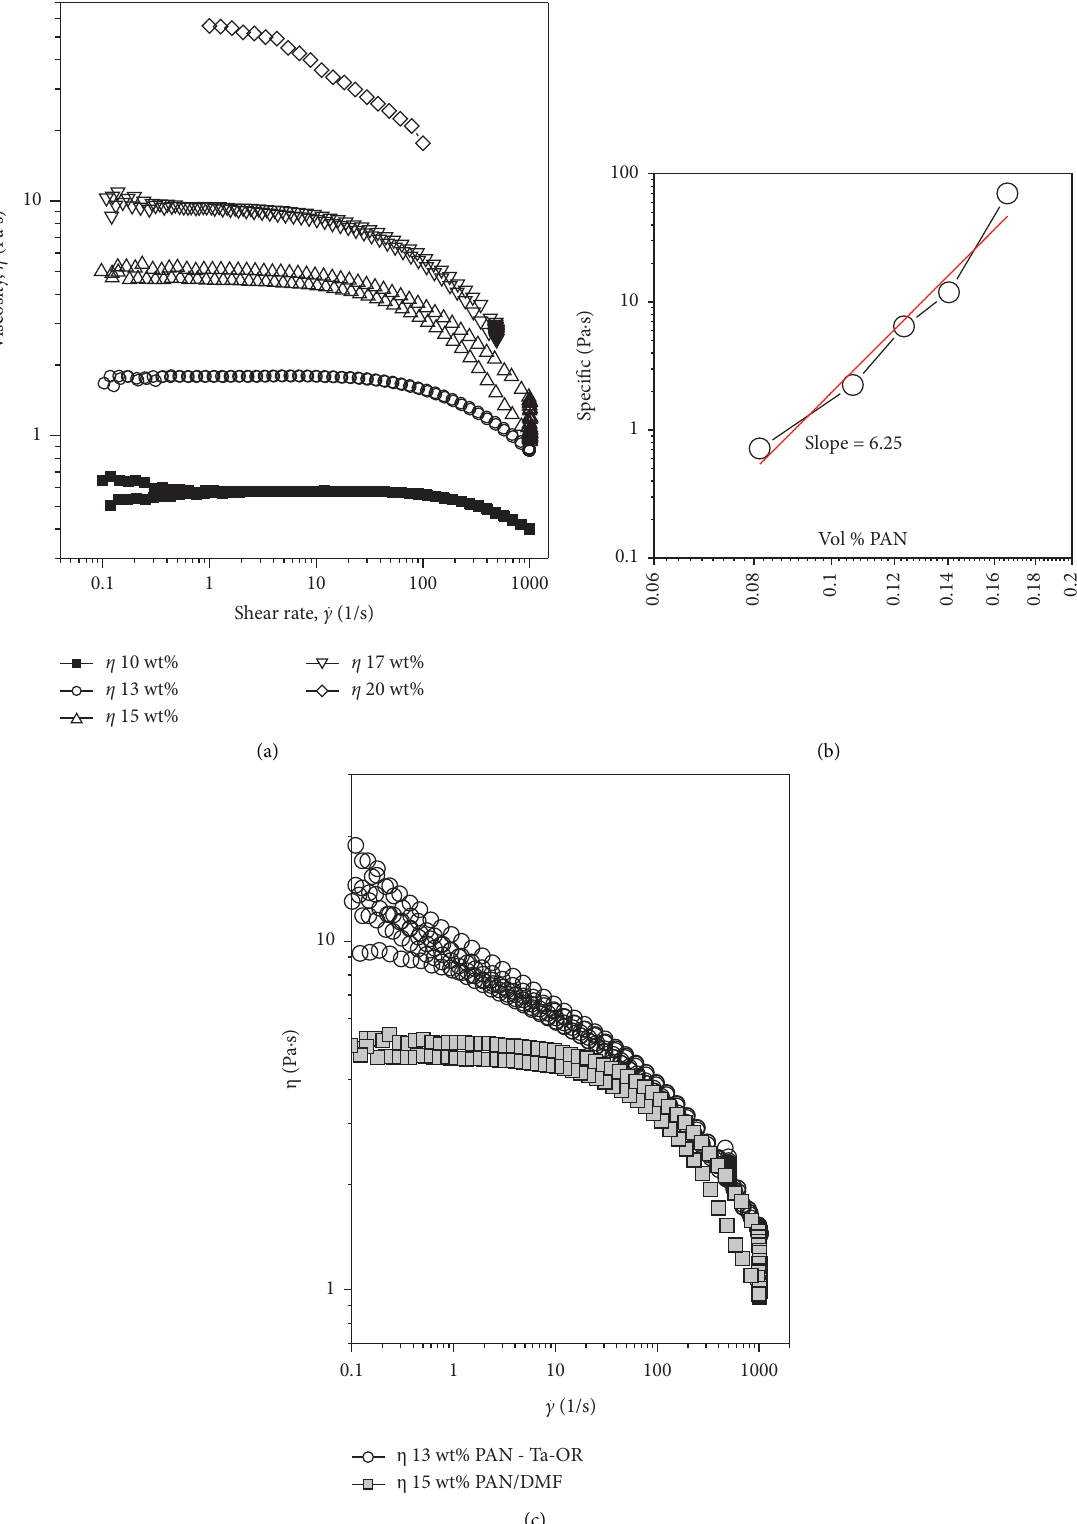
Figure 1: (a) Viscosity versus shear rate of w/w PAN/DMF solution as a function of PAN content. (b) Specific viscosity vs. vol % PAN solution. (c) Comparison of 15 wt % PAN solution to 13 wt % PAN-Ta-OR precursor solution, showing similar high shear rate flow